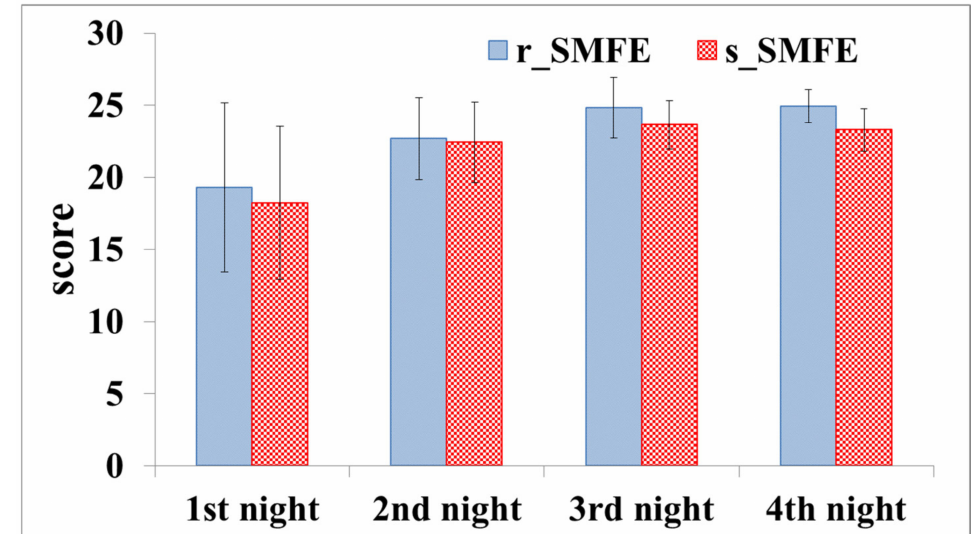
Figure 9. SRSS scores of four nights. The error bars represent the standard